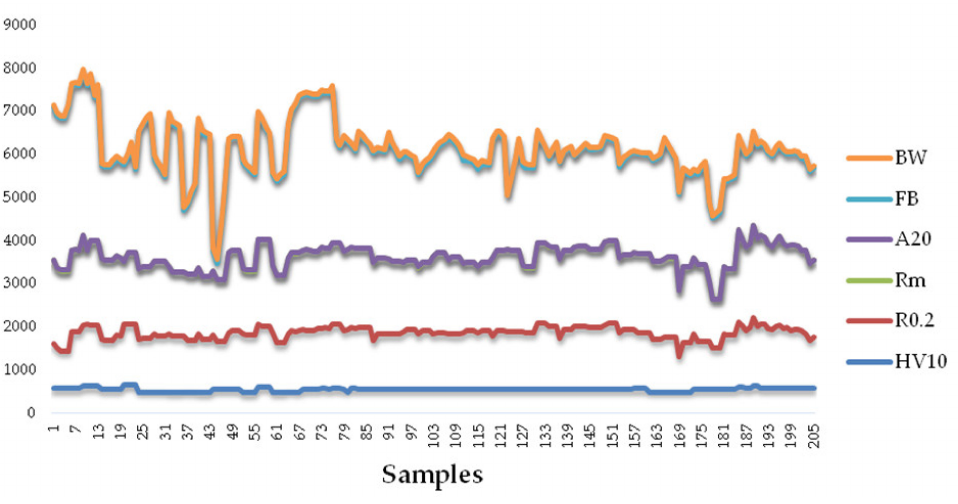
Figure 3. Illustration of the parameters of the alloy, which have been considered inputs for the ML methods.